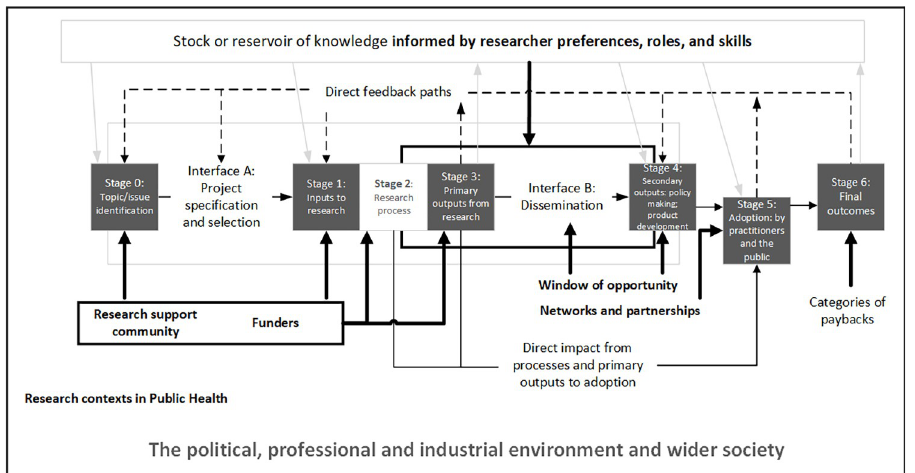
Fig 1. Study findings mapped onto the Payback Framework Logic Model for assessing research impact. The Payback Framework Logic Model with areas for consideration resulting from this research highlighted in bold. The framework was adapted from